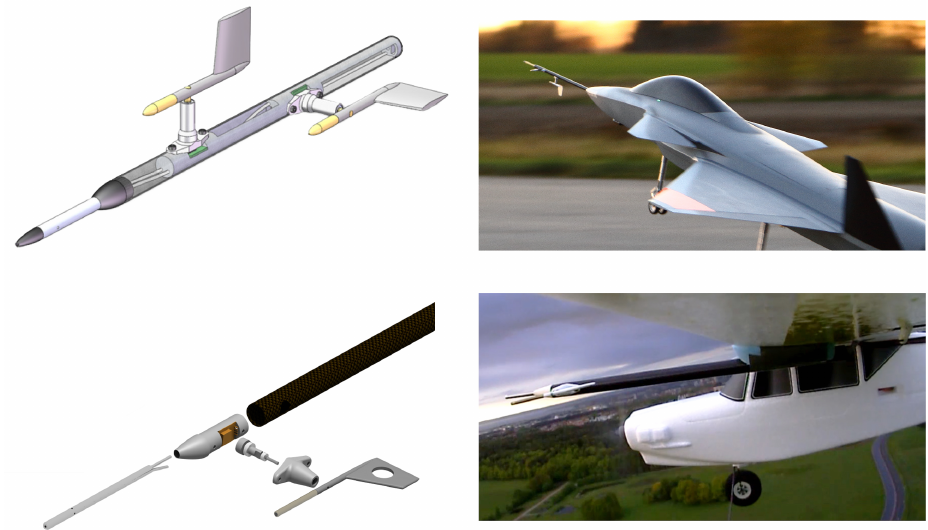
Figure 11. Two airdata probes with contactless flow-angle transducers custom-made for two different applications: A rugged, full pitot-alpha-beta system for high-speed flight using the GFF demonstrator ( top ), and a low-weight, pitot-alpha system with 3D-printed parts developed for a low-speed test-bed aircraft ( bottom